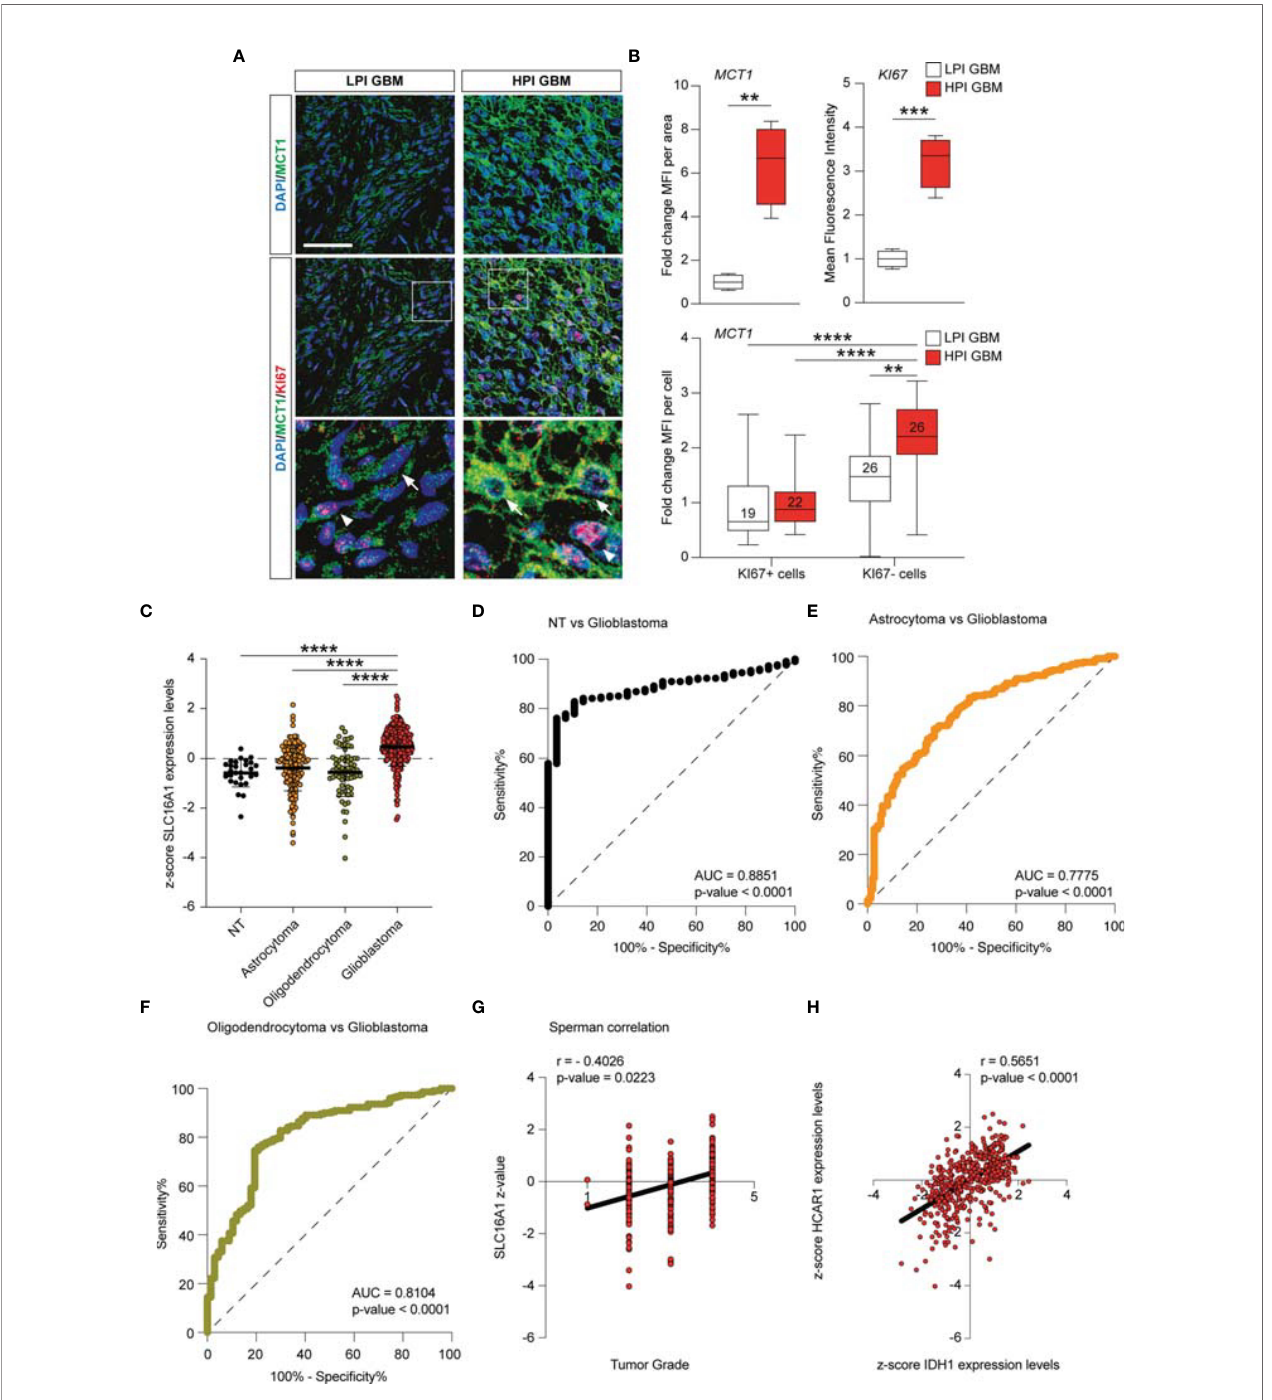
FIGURE 7 | MCT1 expression analysis from the human brain tumor GSE108474 dataset. ( A ) Analysis of the MCT1 gene expression in brain biopsies of patients with astrocytoma, oligodendrocytoma, and glioblastoma (GBM) and in healthy subjects. ( B ) Pearson ’ s correlation analysis between the expression levels of MCT1 and the tumor grade of brain biopsies obtained from patients affected by main brain tumors. ( C ) Pearson ’ s correlation between the expression levels of MCT1 and IDH1 in brain biopsies of patients with GBM. ( D – F ) Receiver operating characteristic (ROC) analysis between the expression levels of MCT1 in the brain in healthy subjects vs. GBM patients ( D ), between GBM patients vs. astrocytoma patients ( E ), and between GMB patients vs. oligodendrocytoma patients ( F ). ( G ) Sperman correlation of SLC16A1 z-value and tumor grade. ( H ) Correlation between HCAR1 and IDH1 expression levels. Data are expressed as the mean ± SD of at least four independent experiments (** p < 0.005; *** p < 0.001; **** p <